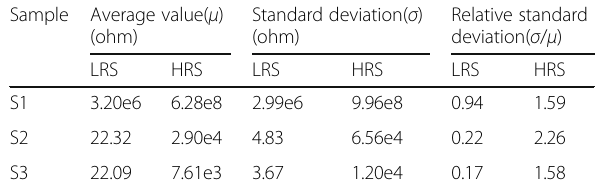
Table 2 The device-to-device variation characteristic of three samples Sample Average value( μ )